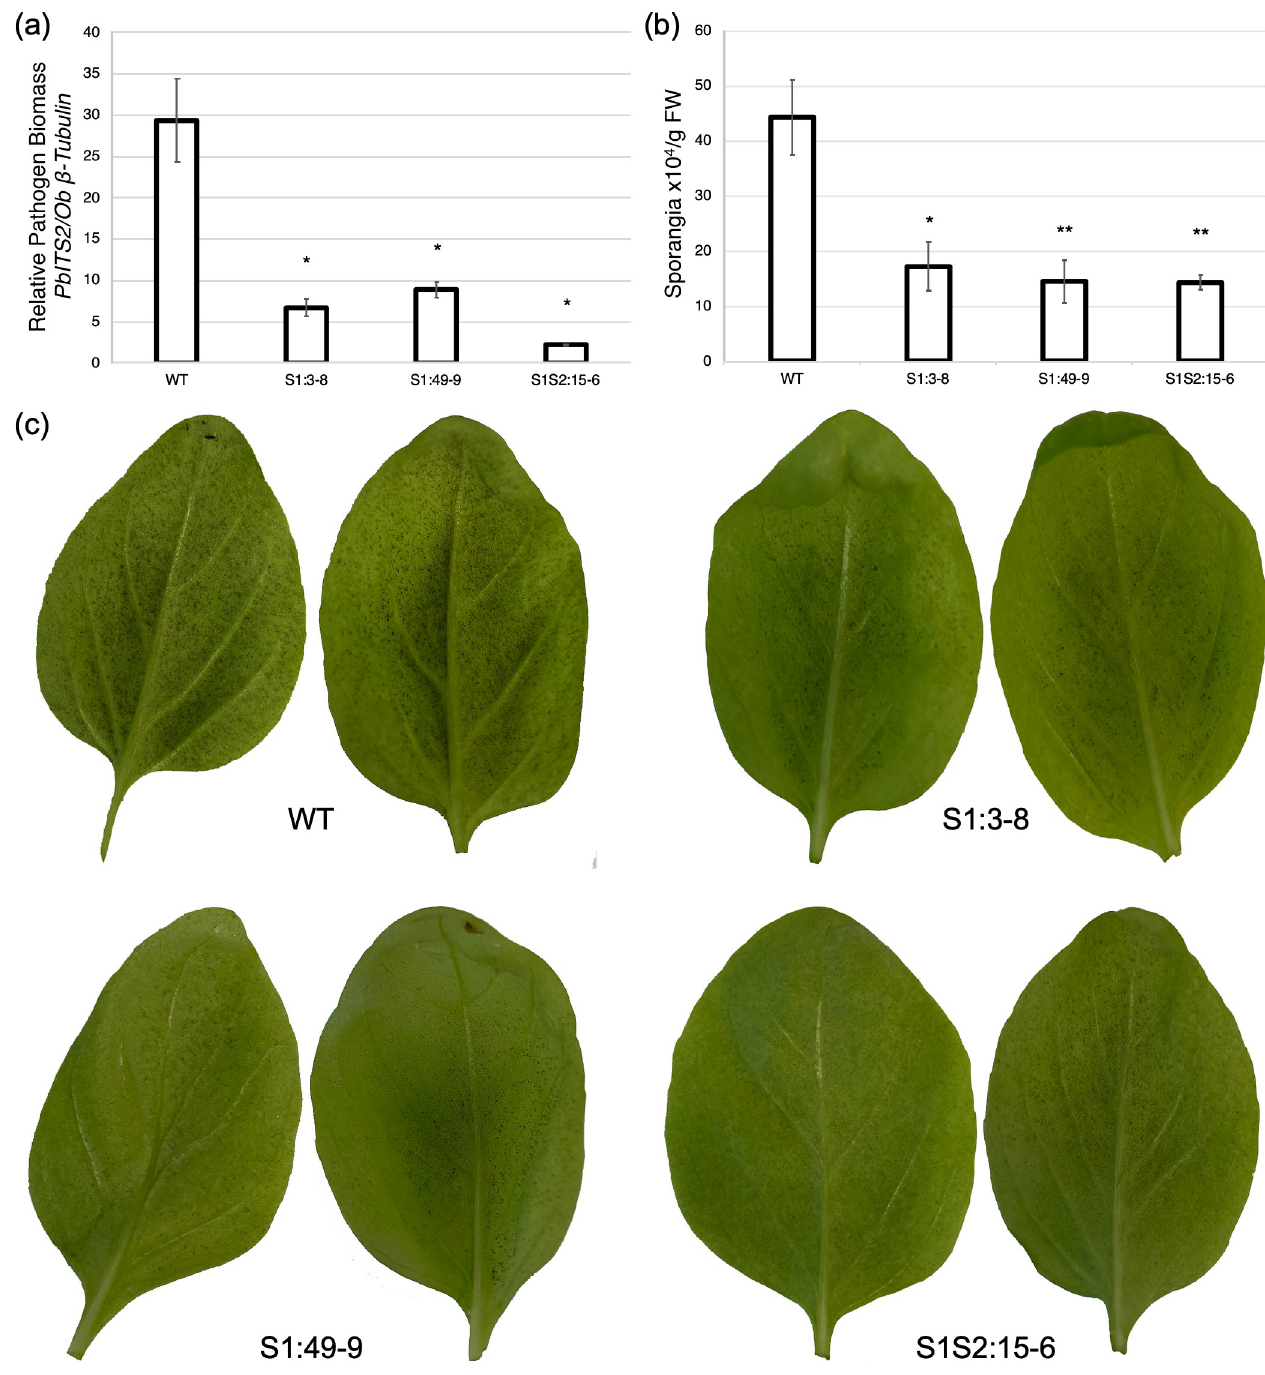
Fig 6. Mutation of ObDMR6 in T2 complete knockout mutants enhances resistance to Peronospora belbahrii . (a) Pathogen biomass determined by qPCR. Infected leaf samples were collected from the wild-type (WT) and T2 plants derived from indicated T1 lines at 4 days post inoculation (dpi). The pathogen biomass was quantified as the ratio of amplification of P . belbahrii ITS2 relative to O . basilicum β -tubulin. Values represent mean ± standard error of three biological replicates with each consisting of two technical replicates. (b) Production of sporangia on inoculated leaves at 9 dpi, calculated as the number of sporangia per gram of fresh weight. Values represent mean ± standard error of three biological replicates. Statistically significant differences between the mutants and WT were determined by one-tailed t test, with one asterisk ( � ) indicating P < 0.05 and two asterisks ( �� ) indicating P < 0.01. (c) Differential basil downy mildew disease levels of WT and T2 plants derived from indicated T1 lines shown with sporulation on the abaxial side of the leaves at 9 dpi. The experiments were repeated three times with similar results.